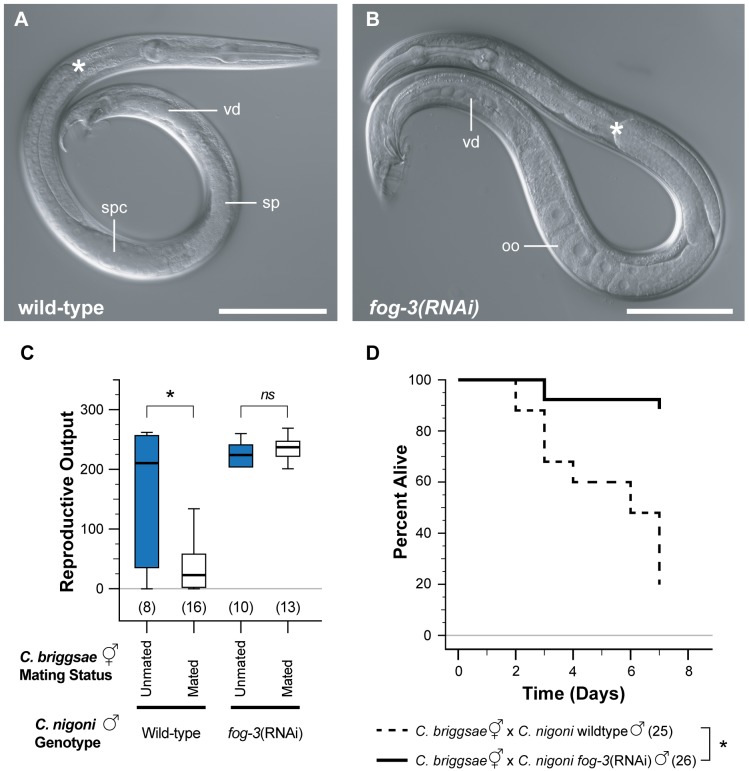
Sperm cause sterility and early mortality in cross-species matings.(A) Wild-type C. nigoni male, with spermatocytes (spc) and sperm (sp) in the seminal vesicle. These are extruded through the vas deferens (vd) during copulation. (B) C. nigoni male treated with maternal Cni-fog-3(RNAi). Oocytes (o) develop instead of sperm, while the somatic testis, including the glandular vas deferens (vd), remain unaffected. (C) The number of viable progeny of C. briggsae hermaphrodites do not differ when unmated (blue) or mated (white) to germline-feminized (fog-3 (RNAi)) C. nigoni males (Mann-Whitney U = 51.5, p = 0.419; ns, not significant), unlike when unmated or mated to wild-type C. nigoni males (U = 26.5, p = 0.019). Boxplot whiskers indicate 1.5× (interquartile range). (D) C. briggsae hermaphrodites mated to Cni-fog-3 (RNAi) males (solid line) have significantly reduced mortality compared to when mated to wildtype C. nigoni males (dashed line; Kaplan-Meier log-rank test: χ2 = 23.7, df = 1, p≤0.001). Sample sizes are shown in parentheses.